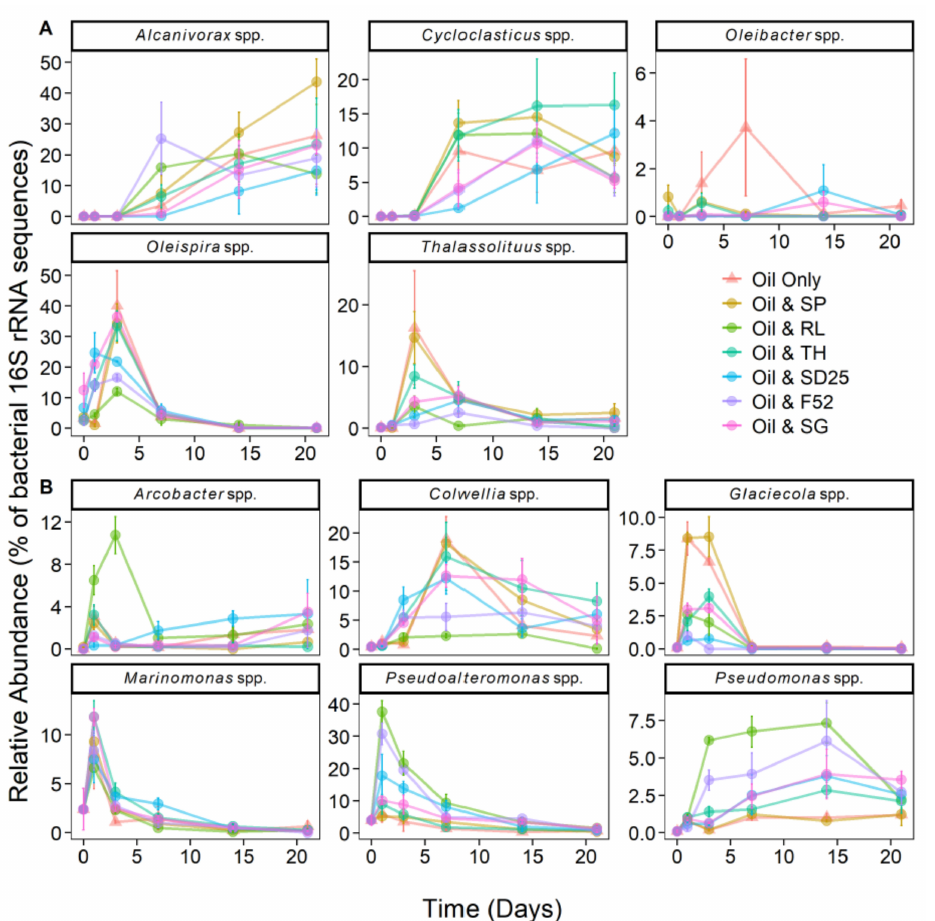
Figure 4. Relative abundance (% of the bacterial community; mean ± SE, n = 3) of 16S rRNA gene sequences within ASVs assigned to obligate hydrocarbonoclastic bacteria ( A ), and bacteria that were abundant (and are often associated with hydrocarbon degradation; see Supplementary Table S2) ( B ), over a 21 day period. All microcosms contained seawater, nutrients, and oil (NSO-1 0.1% v / v ), and some also contained additional dispersants or biosurfactants (0.005% v / v ; 20:1 ratio of oil). Dispersant and biosurfactant codes are as follows: SP = sophorolipid, RL = rhamnolipid, TH = trehalolipid, SD25 = Superdispersant 25, and F52 = Finasol OSR 52, SG = Slickgone